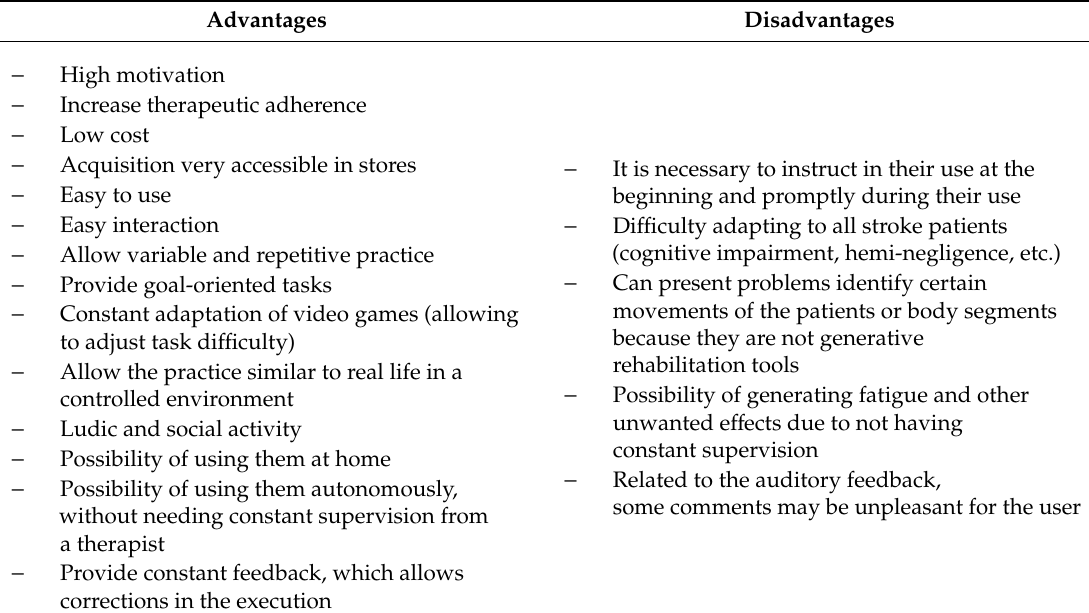
Table 6. Advantages and disadvantages of commercial video